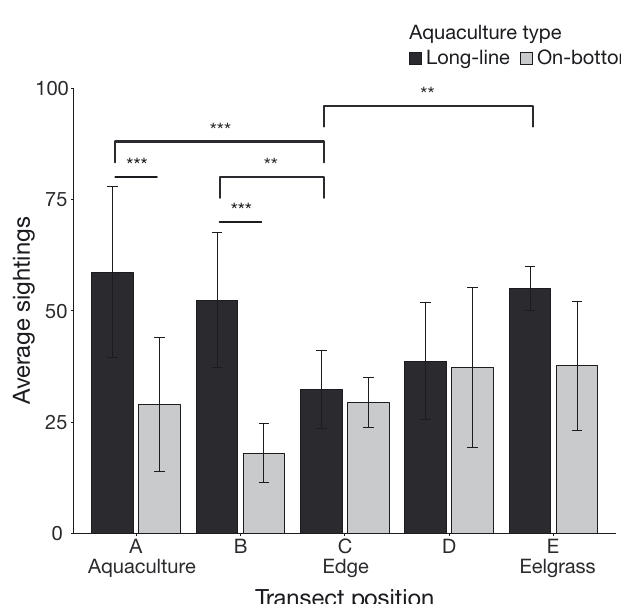
Fig. 4. Average (±1 SE) total sightings of fish and crabs from video data across transects and between aquaculture types (N = 3). Brackets show significant contrasts of interest from simultaneous comparisons of all pairs (significance: **p < 0.01;